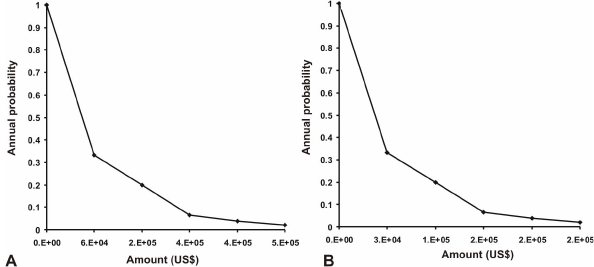
Table 11. Indirect risk to local business.